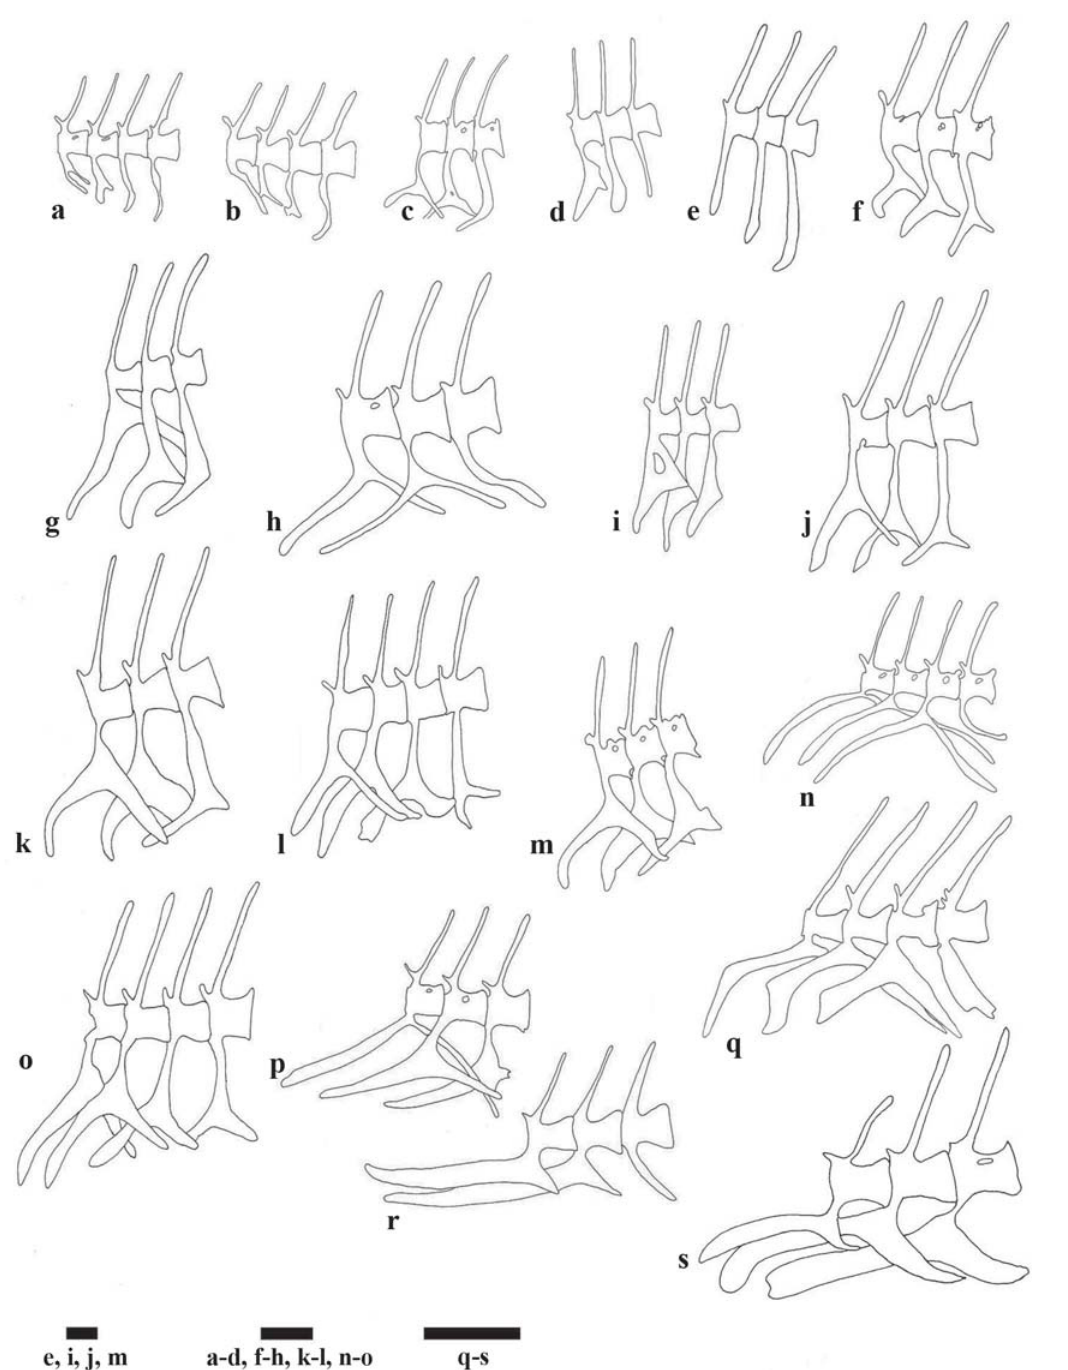
Fig. 10. Lateral view of gonapophyses in: a ) Brachyrhaphis olomina , TU 24997; b ) Brachyrhaphis rhabdophora , TU 84483; c ) Poeciliopsis pleurospilus , USAC 838; d ) Brachyrhaphis episcopi , SU 50303; e ) Xiphophorus alvarezi , USAC 1782; f ) Brachyrhaphis terrabensis , AMNH 20503; g ) Phallichthys fairweatheri , USAC 1797; h ) Poecilia rositae , USAC 1822; i ) Priapichthys annectens , TU 25193; j ) Pseudoxiphophorus bimaculatus , CAS 78795; k ) Poeciliopsis turrubarensis , TU 24130; l ) Pseudoxiphophorus obliquus , LSUMZ 14339; m ) Poeciliopsis gracilis , TU 84966; n ) Phalloceros caudimaculatus , MCP 40527; o ) Pseudoxiphophorus litoperas , USAC 1813; p ) Gambusia affinis , TU 114758; q ) Heterandria formosa , TU 24002; r ) Pamphorichthys araguaiensis , MCP 40919; s ) Phalloptychus iheringi , MCP 11054. Scale bars = 1